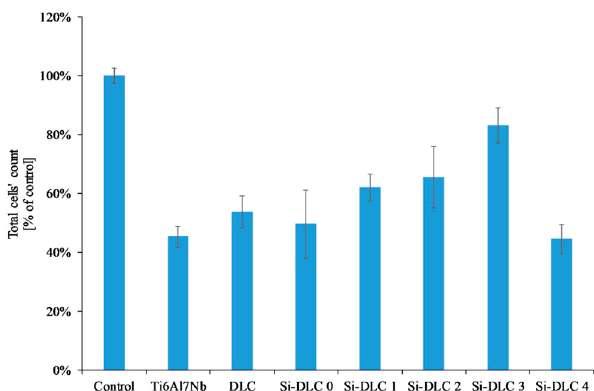
Figure 7. Endothelial cells’ proliferation on the surface of the deposited Si-DLC coatings (live/dead assay).